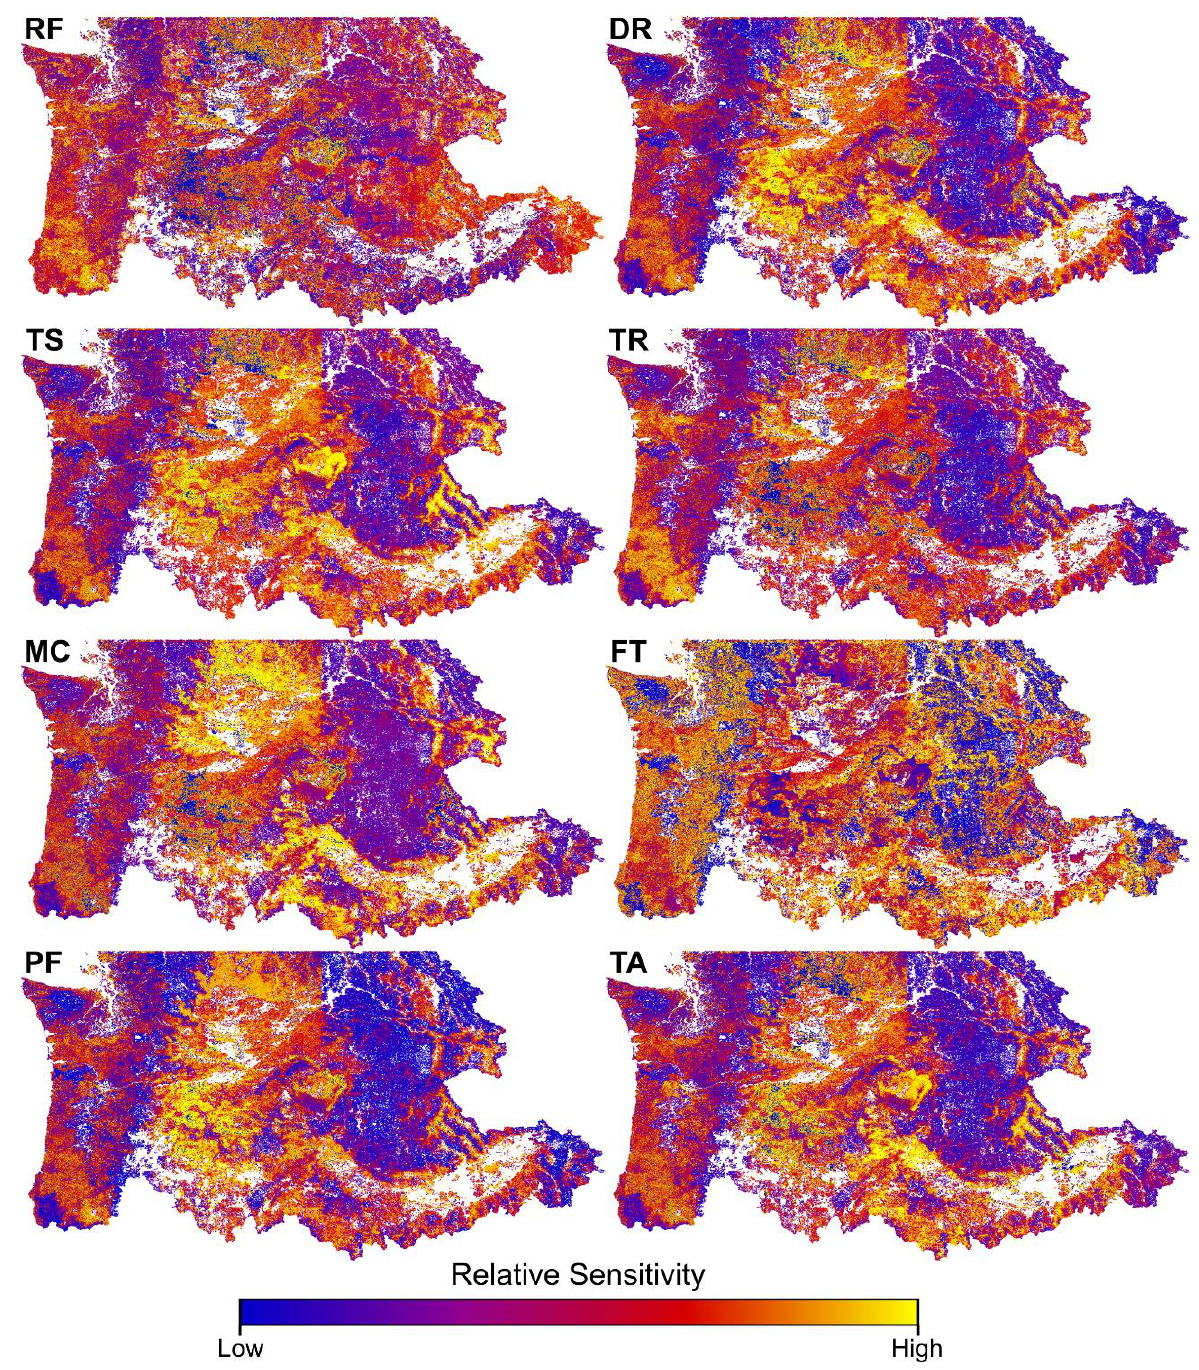
Figure 4. Spatial distribution of the relative sensitivity of stream permanence classification (perma- nent or non-permanent) to the monthly water balance parameters presented in Table 1.